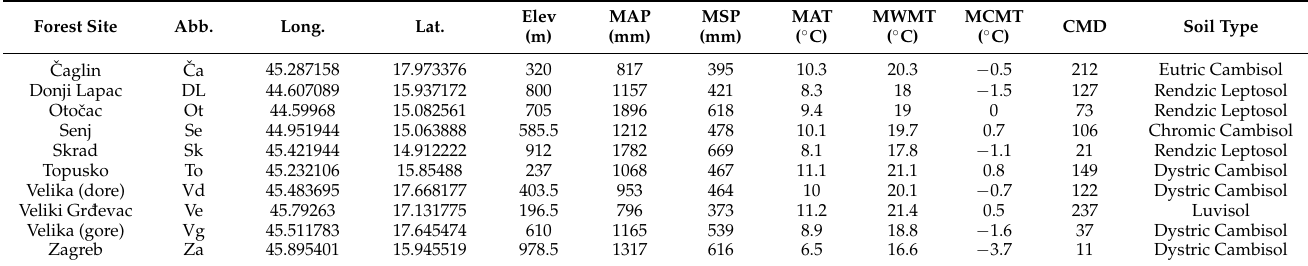
Table 1. Climatic conditions and soil types of the 10 beech habitats of origin. Long. (longitude); Lat. (latitude), Elev. (elevation), MAP (mean annual precipitation), MSP (mean summer precipitation), MAT (mean annual air temperature), MWMT (mean warmest month temperature), MCMT (mean coldest month temperature), mm (millimeters), CMD (see Appendix A), ◦ C (degrees Celsius), m (meters). Growth conditions at the sites were gathered from the Forest Management Plan of Croatian Forests